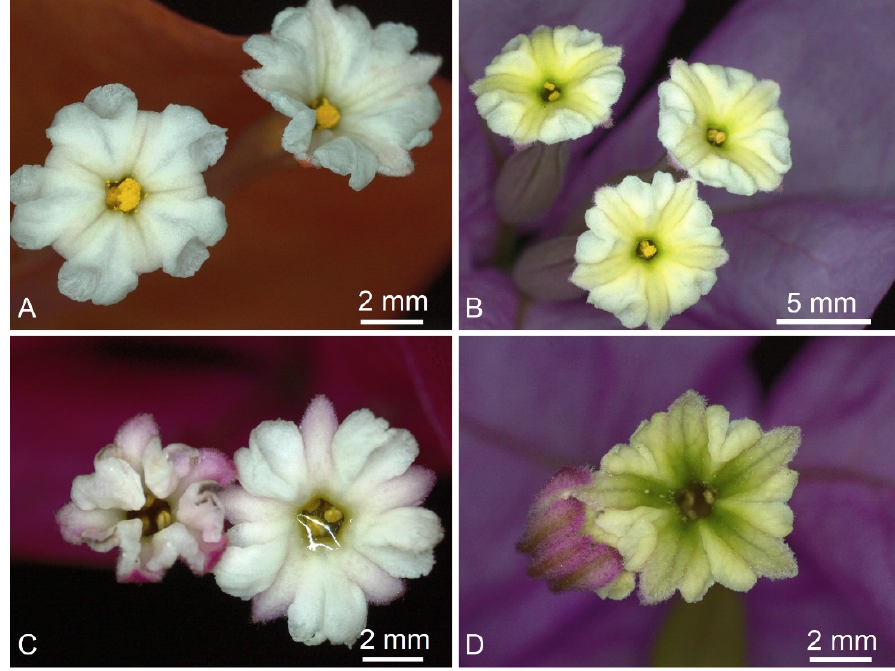
Figure 6. Perianth lobes of species of Bougainvillea and a cultivar: ( A ) Bougainvillea peruviana , ( B ) B. glabra , ( C ) B. cultivar, and ( D ) B. arborea . ( B ) B. glabra , ( C ) B. cultivar, and ( D ) B. arborea .